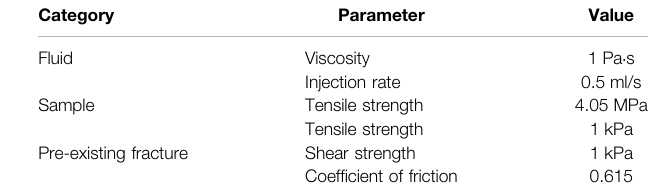
TABLE 2 | Parameters used in the model validation. TABLE 1 | Parameters used in Gu ’ s actual triaxial hydraulic fracturing